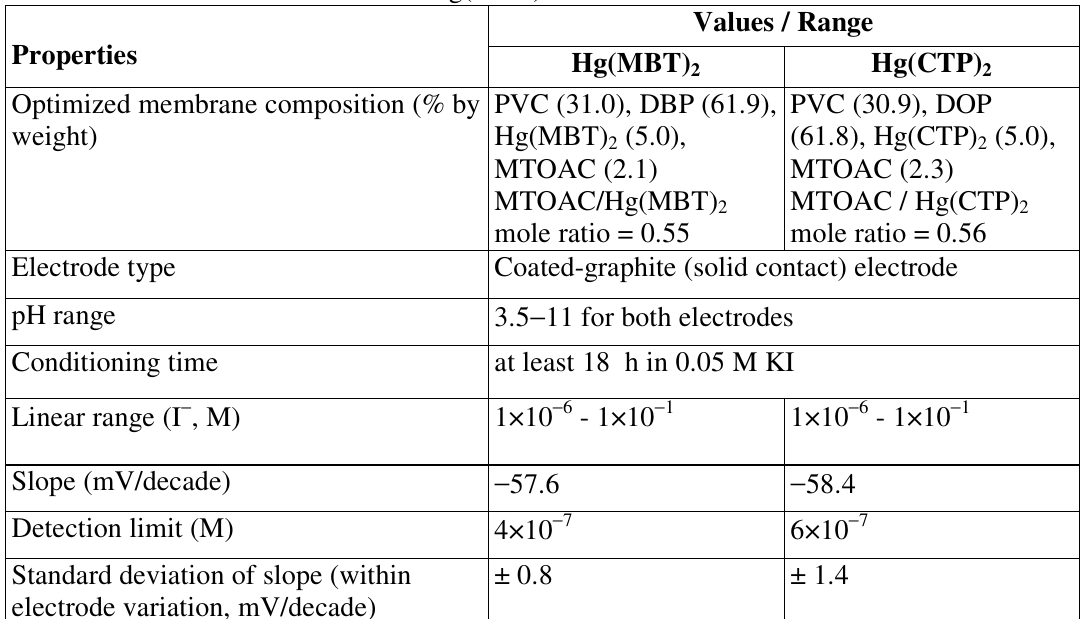
Table 2. Specifications of the Iodide-Selective Electrodes Based on Hg(CTP) 2